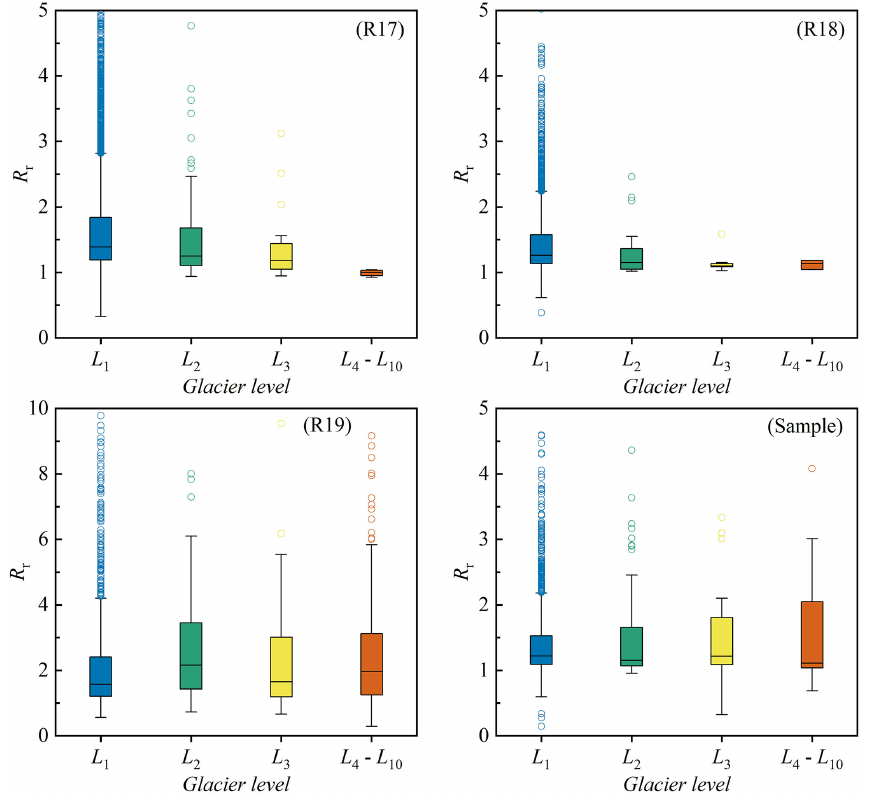
Figure B3. Box plots of the length ratio ( R r ; G Lmax /L max ) of glaciers of distinct grades in every glacier-covered region and whole